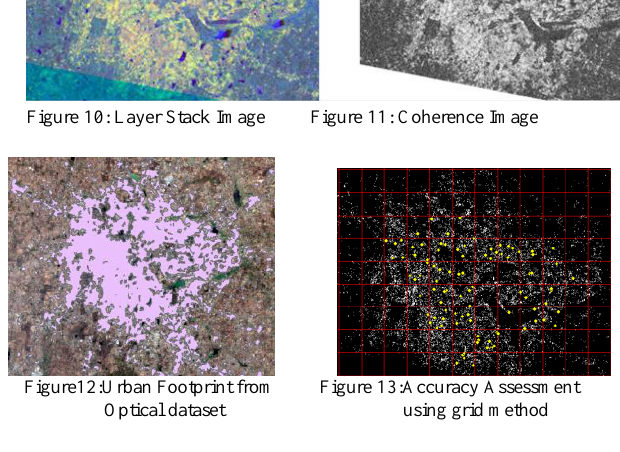
Figure 13:Accuracy Assessment Optical dataset using grid